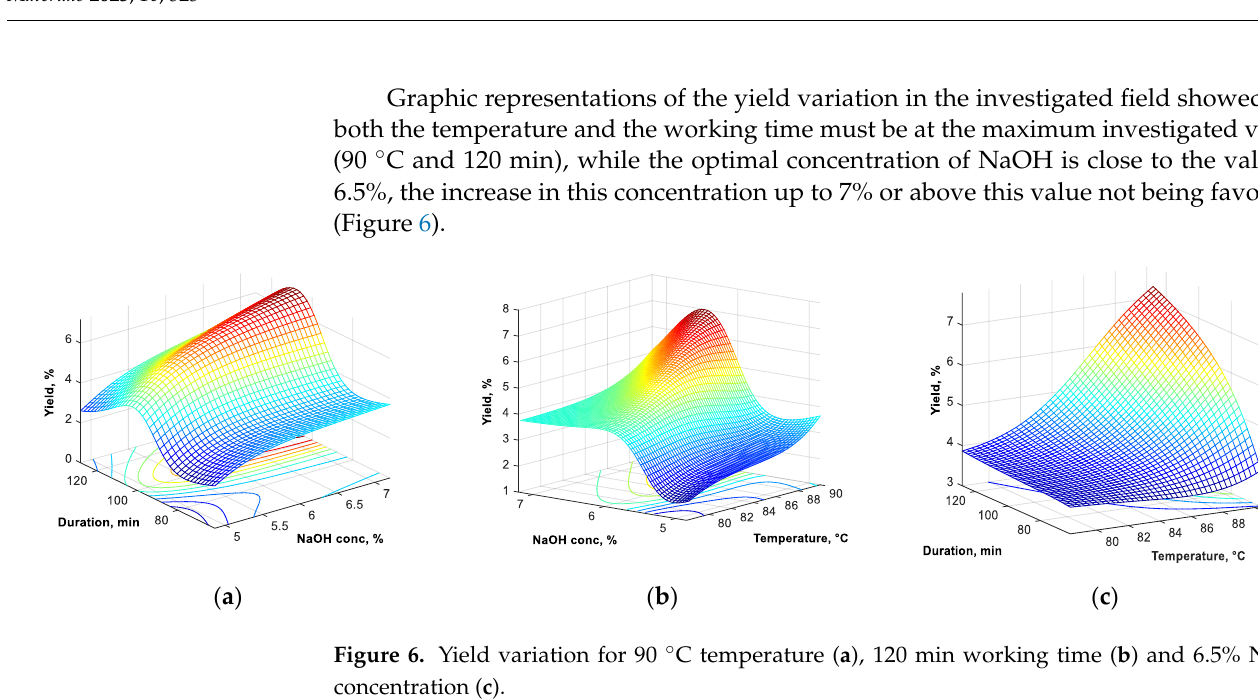
Figure 5. Evolution of the error in approximation of experimental data, during the learning process.